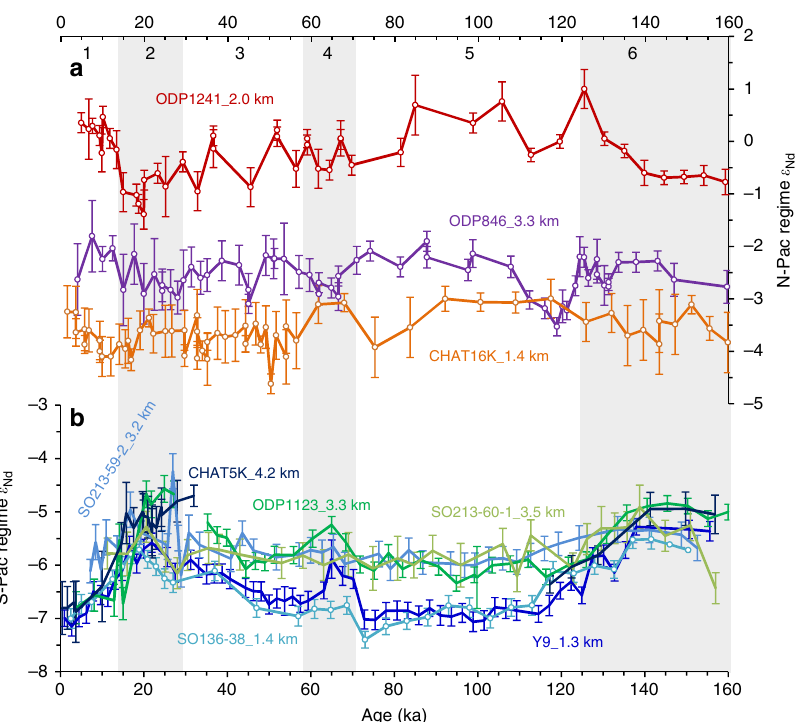
Fig. 6 A compilation of Paci fi c foraminiferal ε Nd records (0 – 160 ka). a N-Pac regime ε Nd patterns. b S-Pac regime ε Nd patterns. The grey bars highlight the glacial stages (MIS 2, 4, and 6). Error bars show the 2 σ external error of the ε Nd